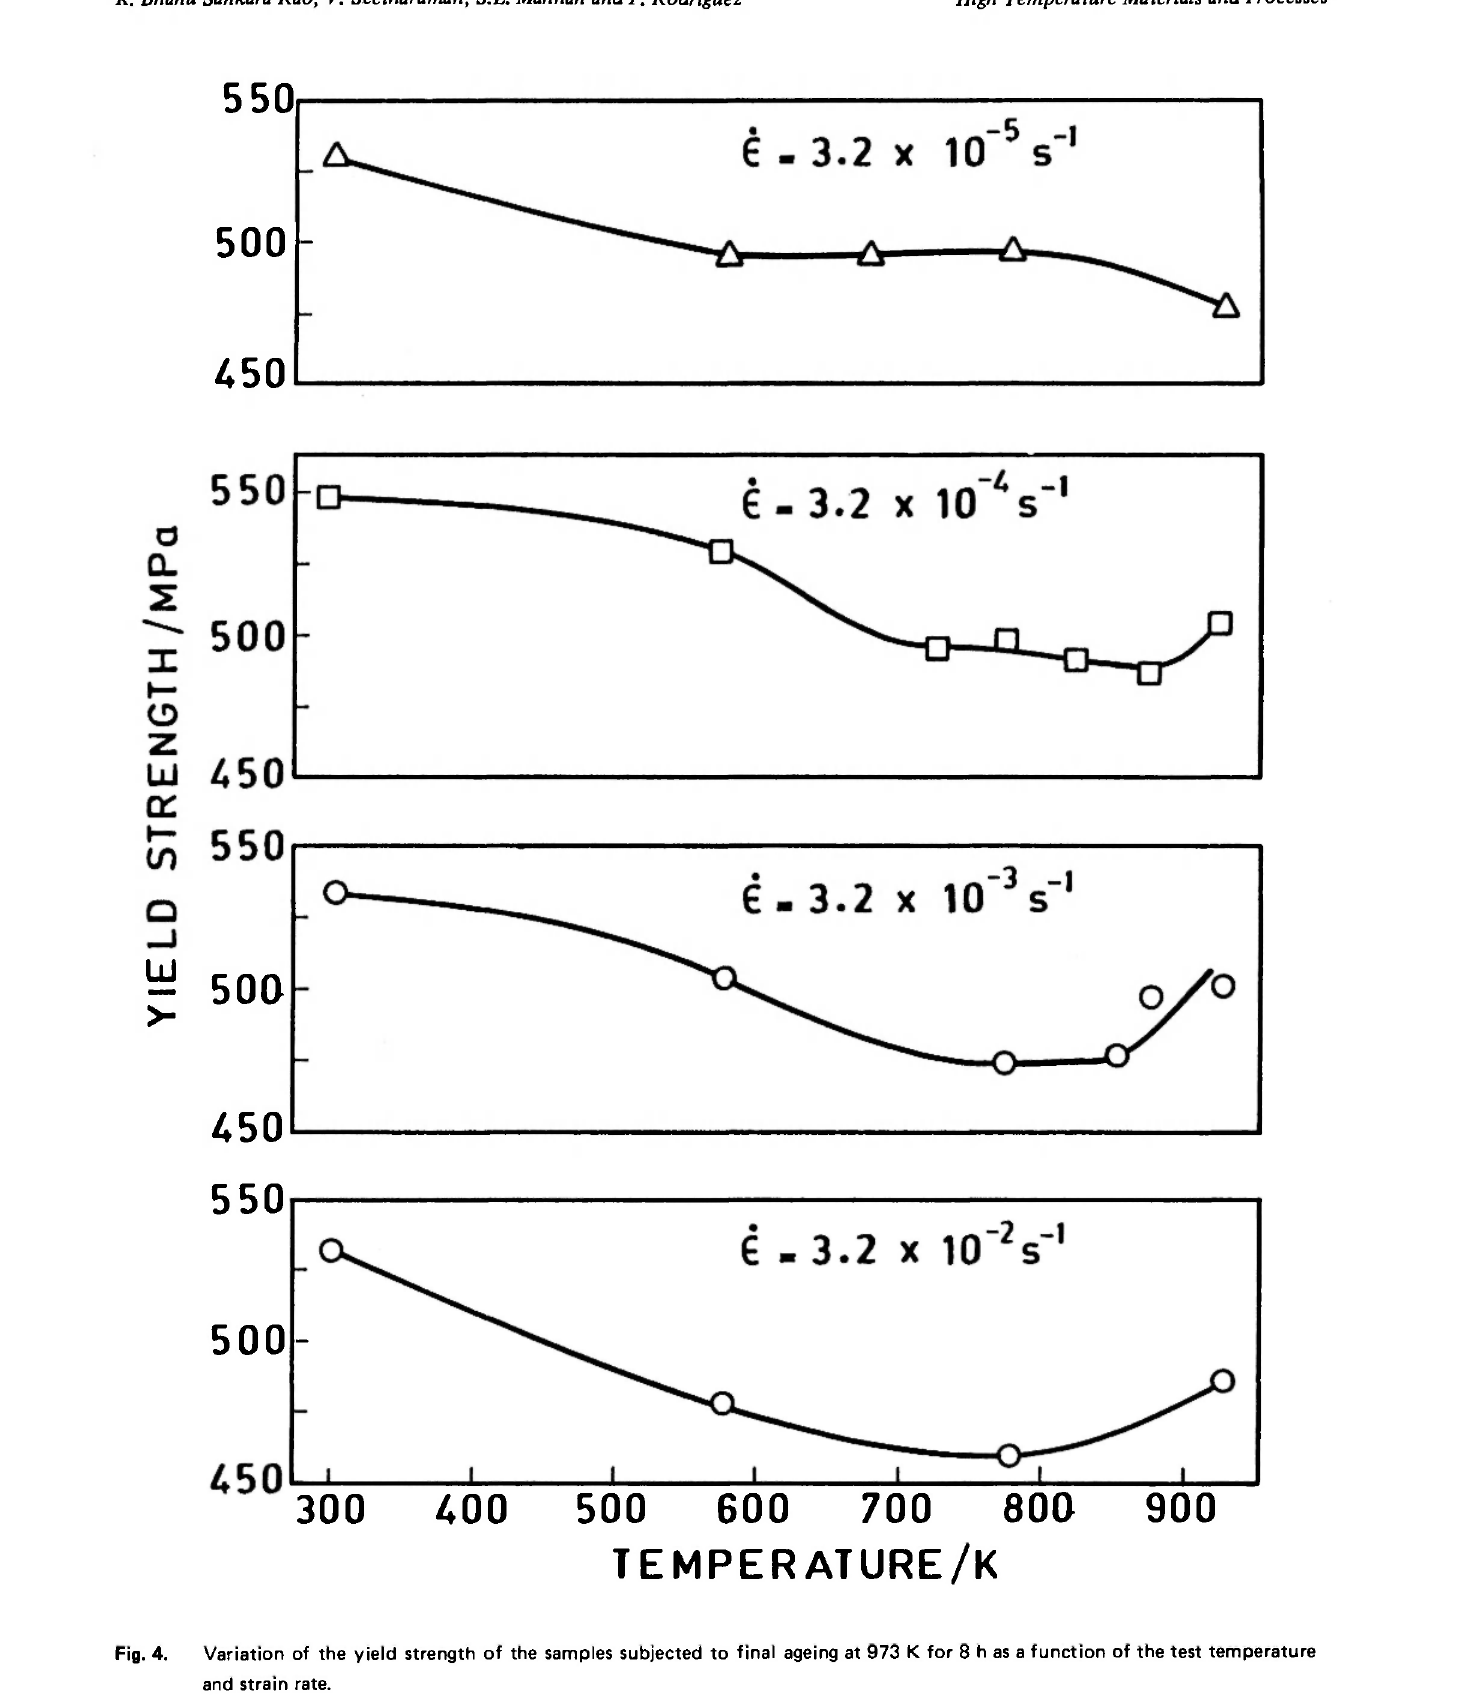
Fig. 4. Variation of the yield strength of the samples subjected to final ageing at 973 Κ for 8 h as a function of the test temperature and strain